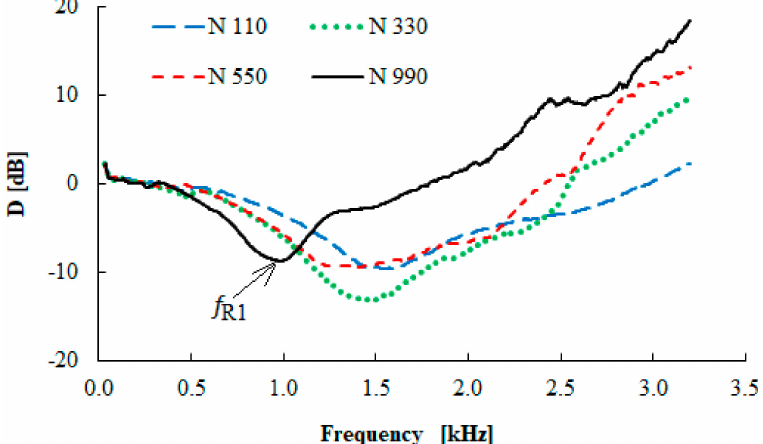
Figure 12. Frequency dependence of the transfer damping function (D) for the tested rubber composite measuring t = 10 mm in thickness, without inertial mass (m = 0 g).